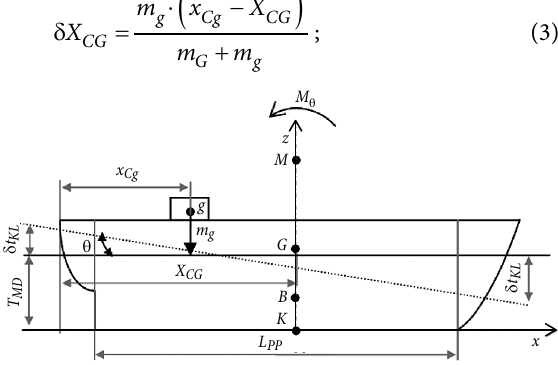
Fig. 7. Trim of ship with